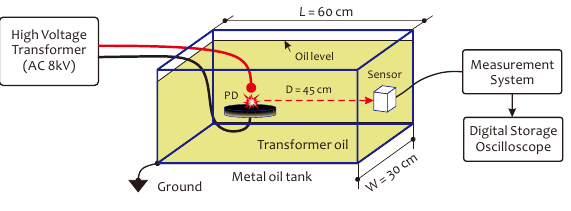
Figure 16. Experimental setup for discharge detections.